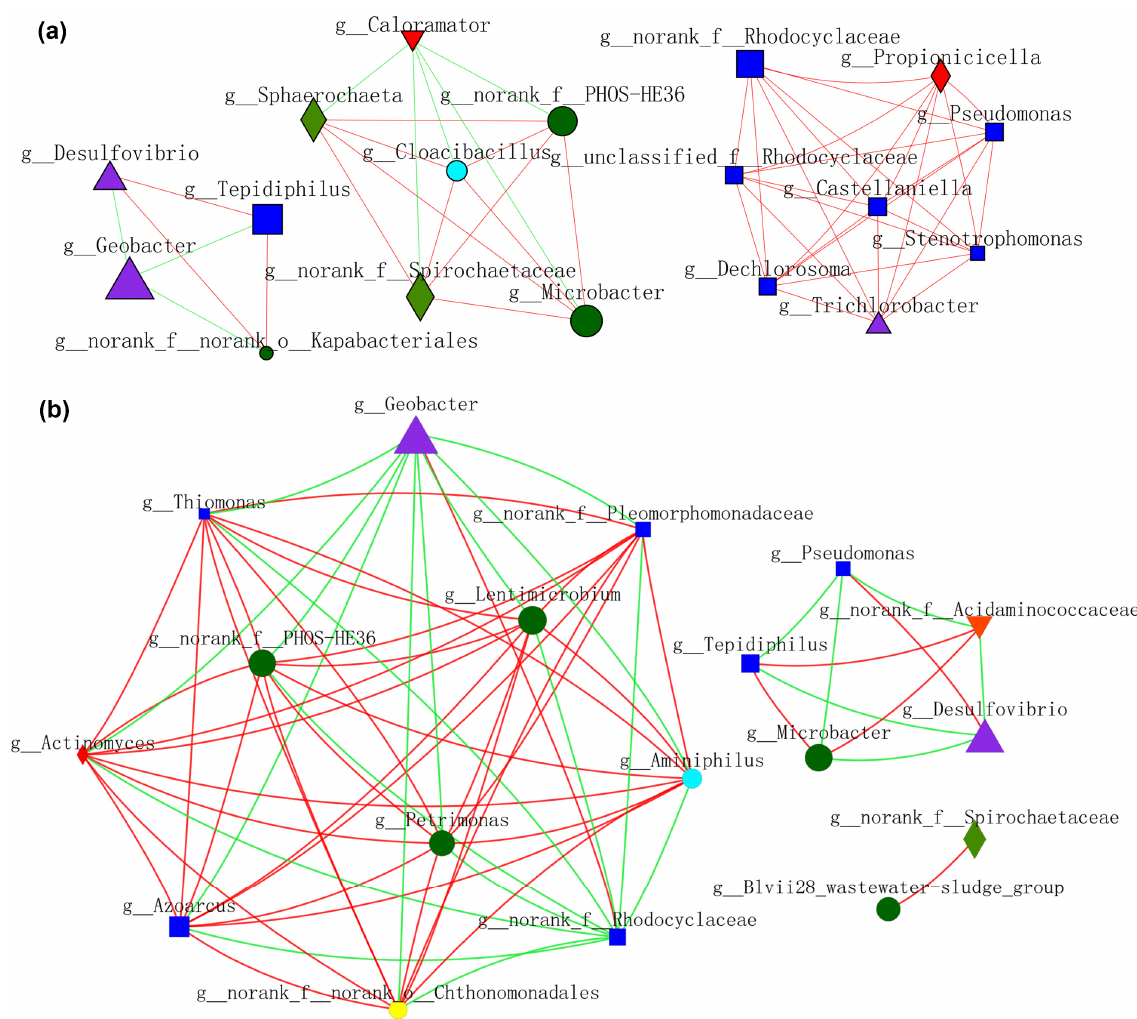
Figure 10. Molecular ecological networks (MEN) visualization dominated by ( a ) planktonic_CC and ( b ) planktonic_S10. Different colors and shapes of nodes signifier categories of phylum: Proteobacteria (deep blue diamond), Bacteroidota (deep green round), Desulfobacterota (purple triangle), Synergistota (sky blue round), Armatimonadota (yellow round), Firmicutes (red diamond), Actinobacteriota (red inverted triangle), Spirochaetota (light green diamond). A red edge indicates a positive interaction between two individual nodes, while a green edge indicates a negative interaction.